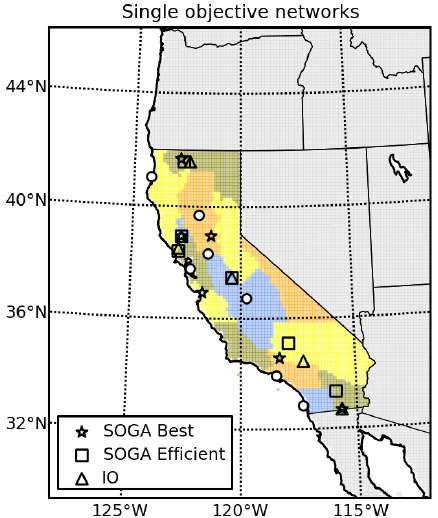
Figure 5. The figure shows the locations of observing stations in the SOGA Best case (stars), SOGA Efficient case (squares), and IO case (triangles). Reference locations of the seven existing observing sites are also shown (white